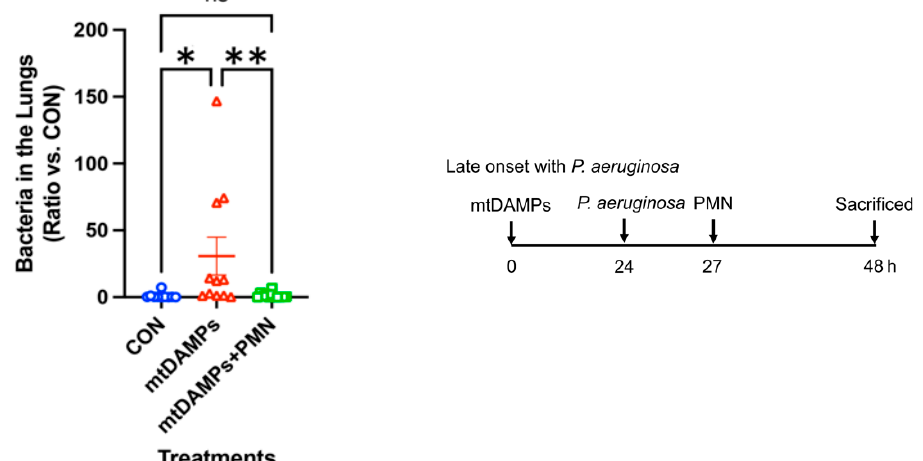
Figure 2. Effects of mtDAMPs and external mouse PMN on P. aeruginosa clearance (PA) in lung. Left: CD-1 mice were separated into three groups. 1. CON: Saline i.p. injection (time 0) followed by P. aeruginosa (24 h) i.t. 2. mtDAMPs: mtDAMPs i.p. (time 0) followed by P. aeruginosa i.t. (24 h), 3.